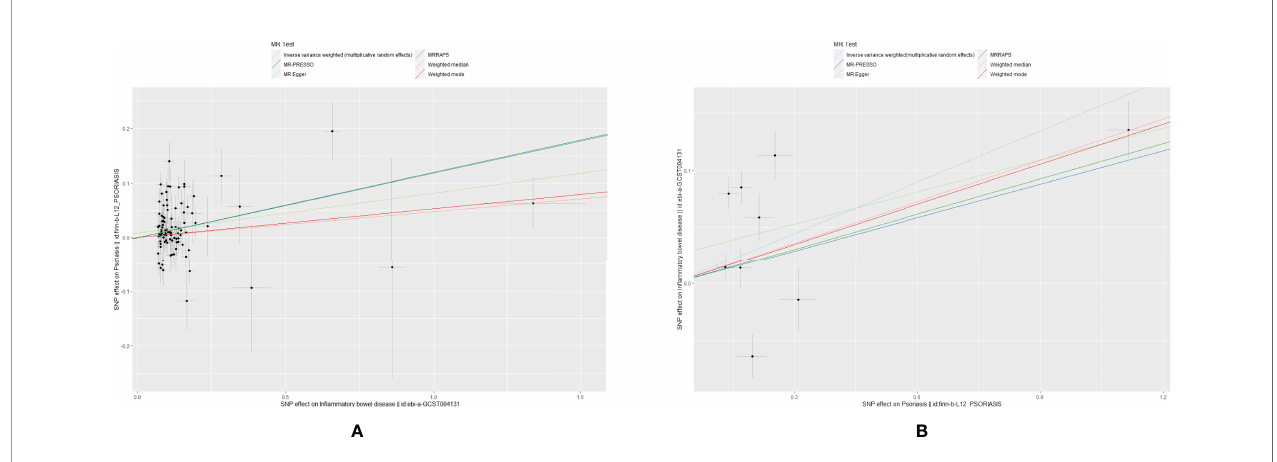
FIGURE 2 | Scatter plots of primary MR analysis. The slope of each line corresponding to the estimated MR effect in different models. (A) IBD on psoriasis; (B) Psoriasis on